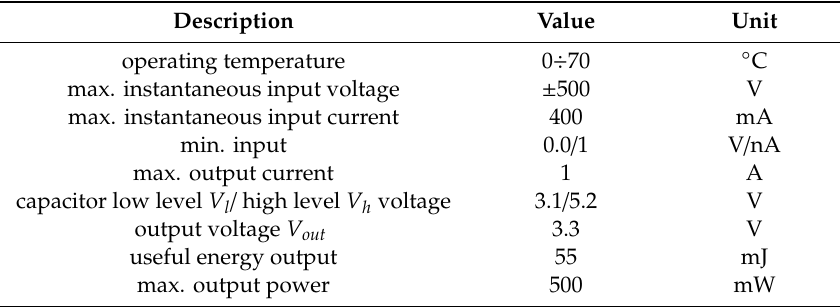
Table 2. Module EH301A technical data.